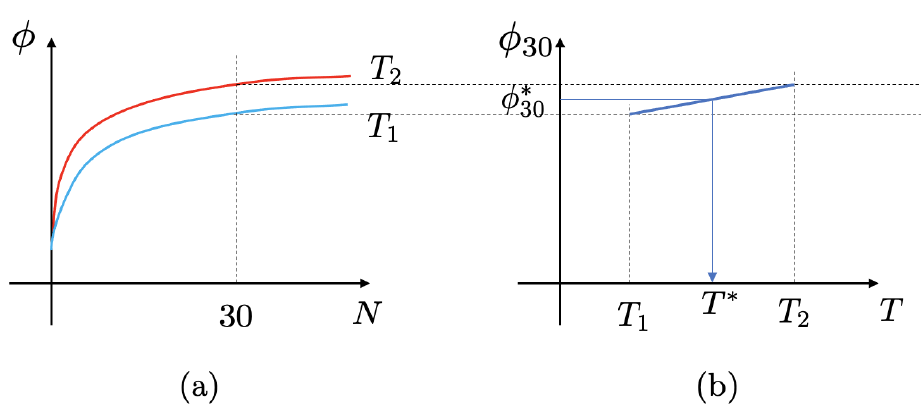
Figure 10. A schematic diagram for compaction temperature estimation: ( a ) Gyratory compaction curves at multiple temperatures, ( b ) compaction temperature interpolation.